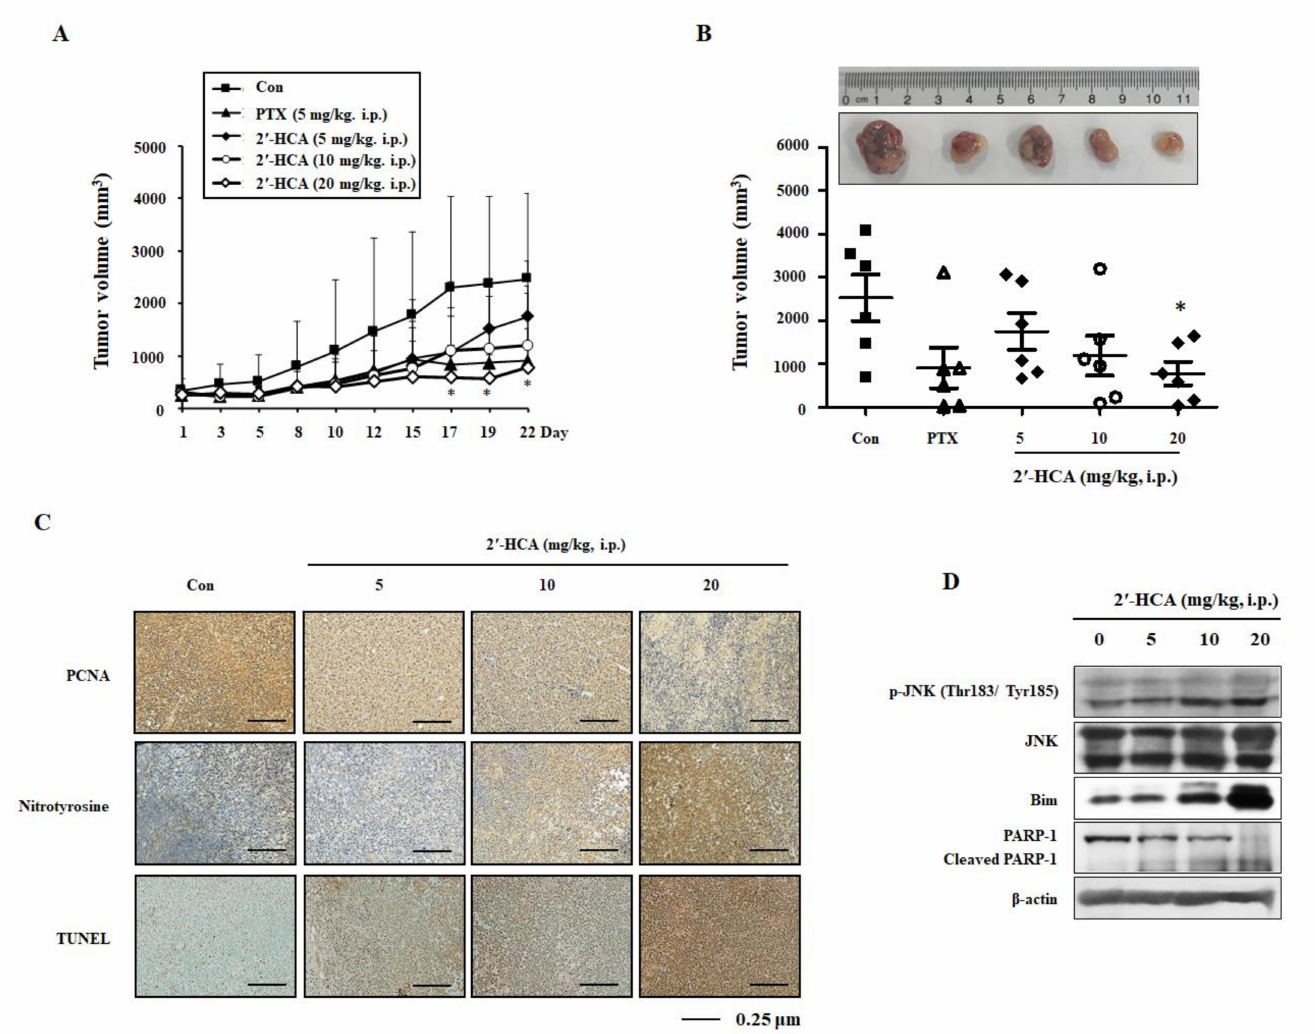
Figure 8. Effect of 2 (cid:48) -HCA on tumor growth in a HL-60 xenograft mouse model. ( A ) The tumor volume (mm 3 ) was measured throughout the experimental period, and ( B ) representative tumors were selected after the mice were sacrificed. Data are presented as the mean ± SD (n = 6). * p < 0.05 vs. control group. ( C ) The expression levels of PCNA and nitrotyrosine were analyzed by IHC and apoptosis induction was examined by TUNEL assay in tumor tissues. ( D ) Intratumoral expression of p-JNK, Bim, and PARP-1 were evaluated by western blotting. β -actin was used as an internal